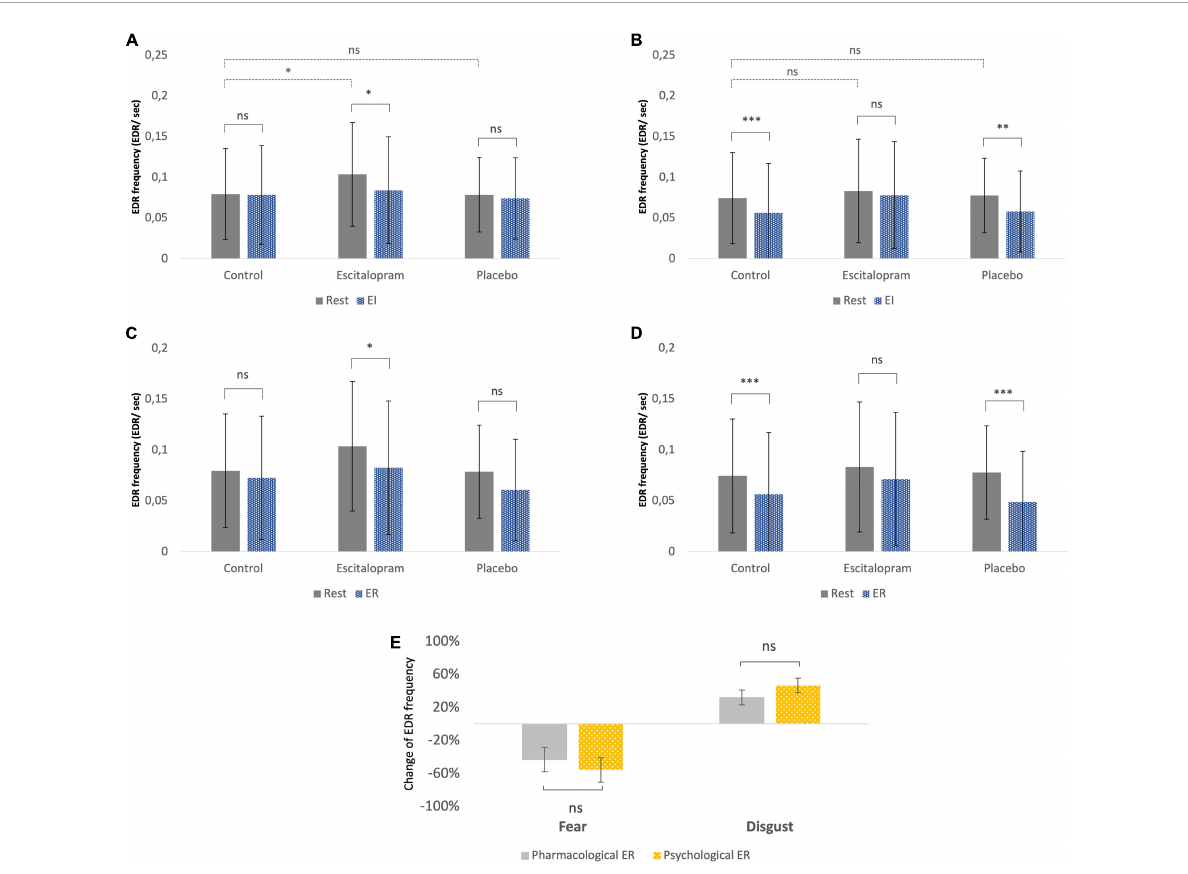
FIGURE4 Autonomic measures (electrodermal activity – EDA frequency). (A) Fear, emotion induction. (B) Disgust, emotion induction. (C) Fear, emotion regulation. (D) Disgust, emotion regulation. The EDR labeling in the Y -axon includes both spontaneous NS-EDR (Rest columns) and stimulus-evoked EDR (EI and ER columns). (A,B) The dotted line comparisons in A (fear) and B (disgust) show that compared to control phase, after ingestion of escitalopram, a roughly 30% increase in electrodermal response frequency was measured at rest (absence of emotive stimuli) during the fear experiments but not the disgust ones. (A–D) The solid line comparisons show that, similarly to what was previously reported in a study without pharmacological intervention (61), placebo was associated with no difference between task EDA and rest in fear (A,C) but lower than rest in disgust (B,D) . This pattern was reversed in the escitalopram arm, where task EDA was significantly lower than rest in fear (A,C) but not significantly different than rest in disgust (B,D) . Shown mean EDA frequency, EDR per second, and SD. (E) Emotion regulation with reappraisal and escitalopram did not differ significantly regarding the effects on EDA. Shown mean change in EDA frequency (EDR per second) and SE of this difference. *** p < 0.001, ** p < 0.01, and * p < 0.05. Pharmacological ER = (EDA EI in control – EDA EI in intervention phase)/EDA